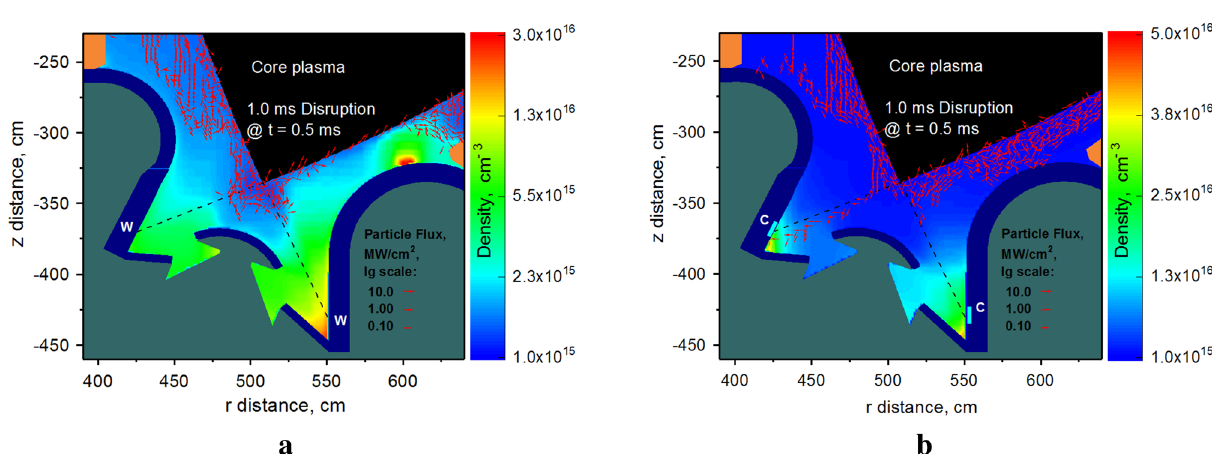
Figure 7. Snapshot of calculated of core plasma particle flux (vectors to scale) at t = 0.5 ms during 1.0 ms disruption on background of secondary plasma atomic density: tungsten SP ( a ), carbon insert at SP ( b ). The images were prepared using OriginPro